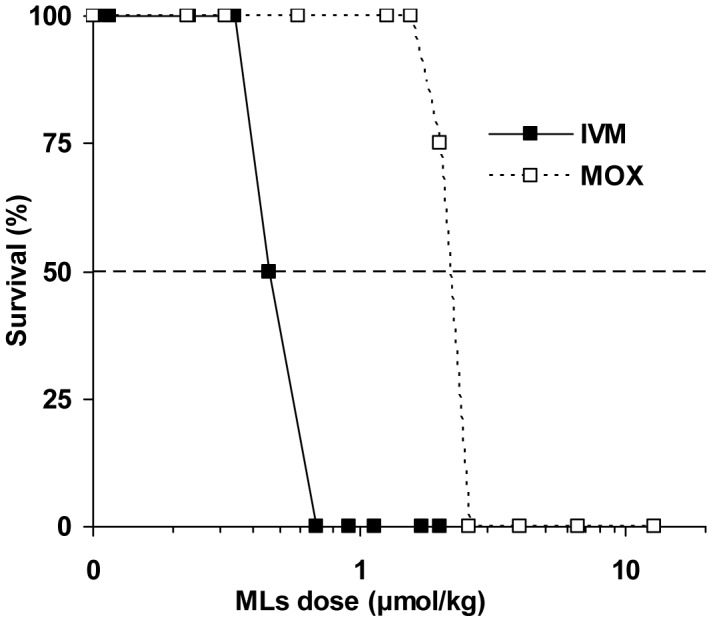
Acute toxicity of IVM and MOX in Mdr1ab(−/−) mice.Acute toxicity was determined by observing survival during a 14-day period after subcutaneous administration of IVM (black square) or MOX (open square) to small groups (2–8 animals) of Mdr1ab(−/−) mice. Extrapolation from the graph yields an estimated LD50 of 0.46 µmol/kg (0.40 mg/kg) and 2.3 µmol/kg (1.47 mg/kg) for IVM and MOX, respectively.